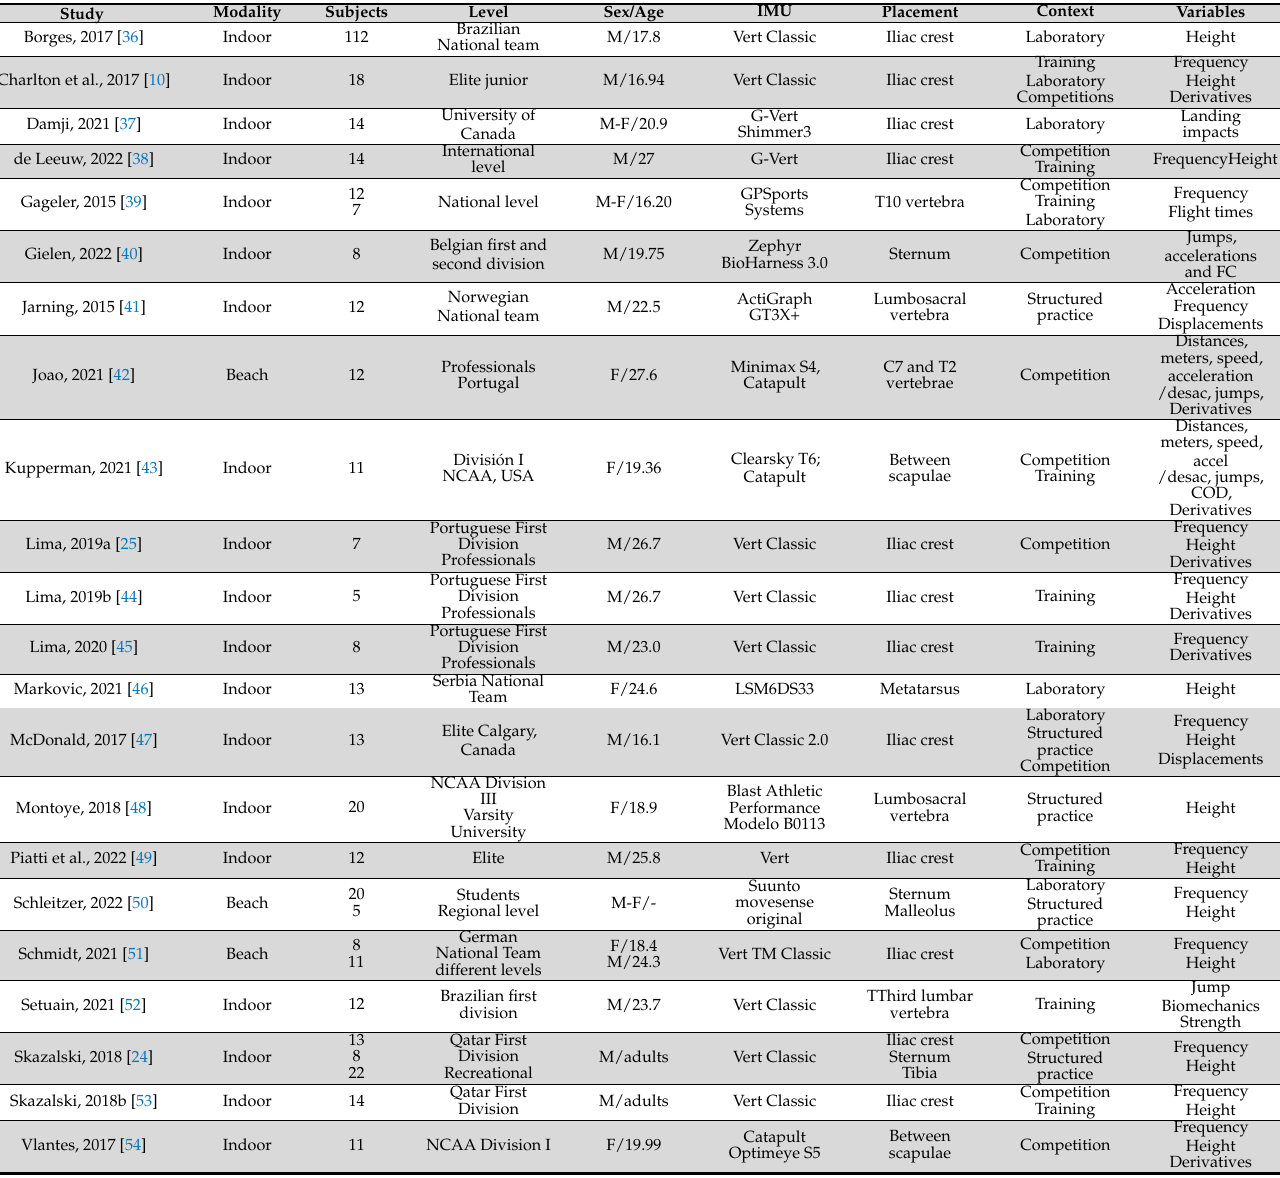
Table 3. Methodological characteristics of the studies